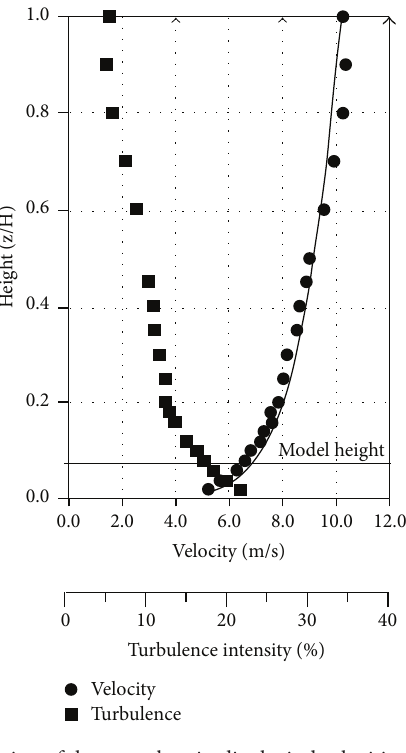
Figure 14: Vertical distribution of the mean longitudinal wind velocities and turbulence intensities.